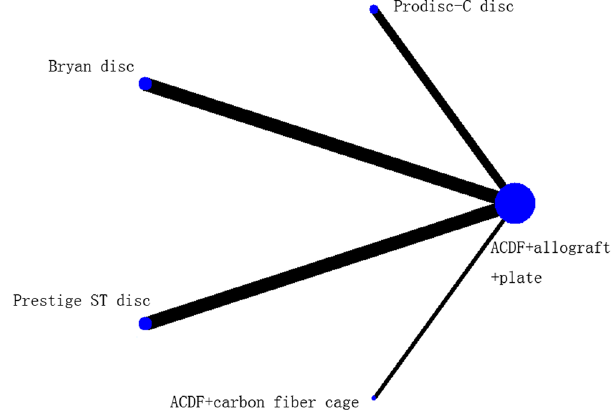
Figure 3. Network plot for NDI score.